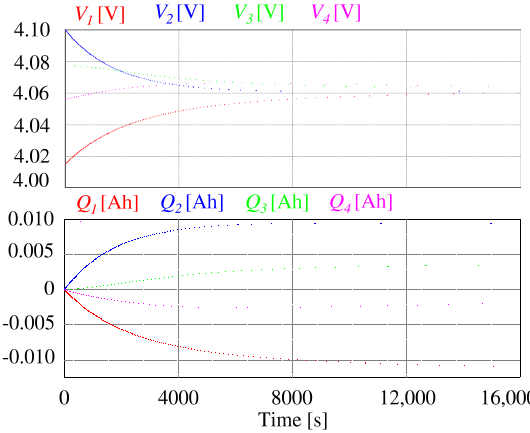
Figure 10. Equalization of a four-cell battery bank using the switched capacitor scheme.